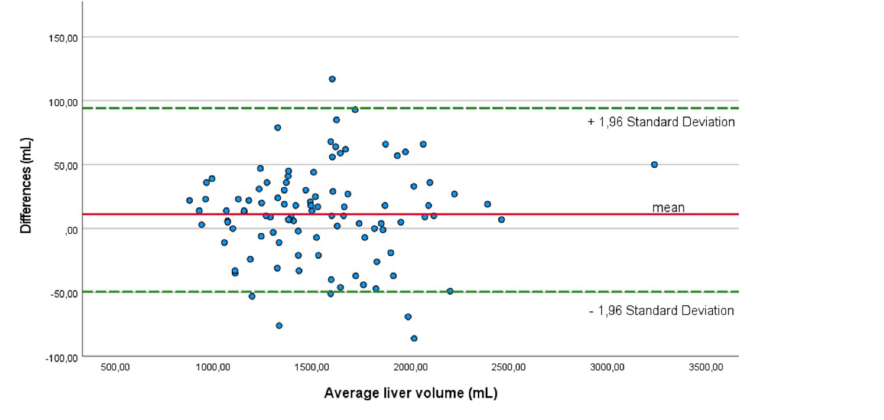
Fig 2. Bland-Altman-Plot for radiologist #1 and #2.